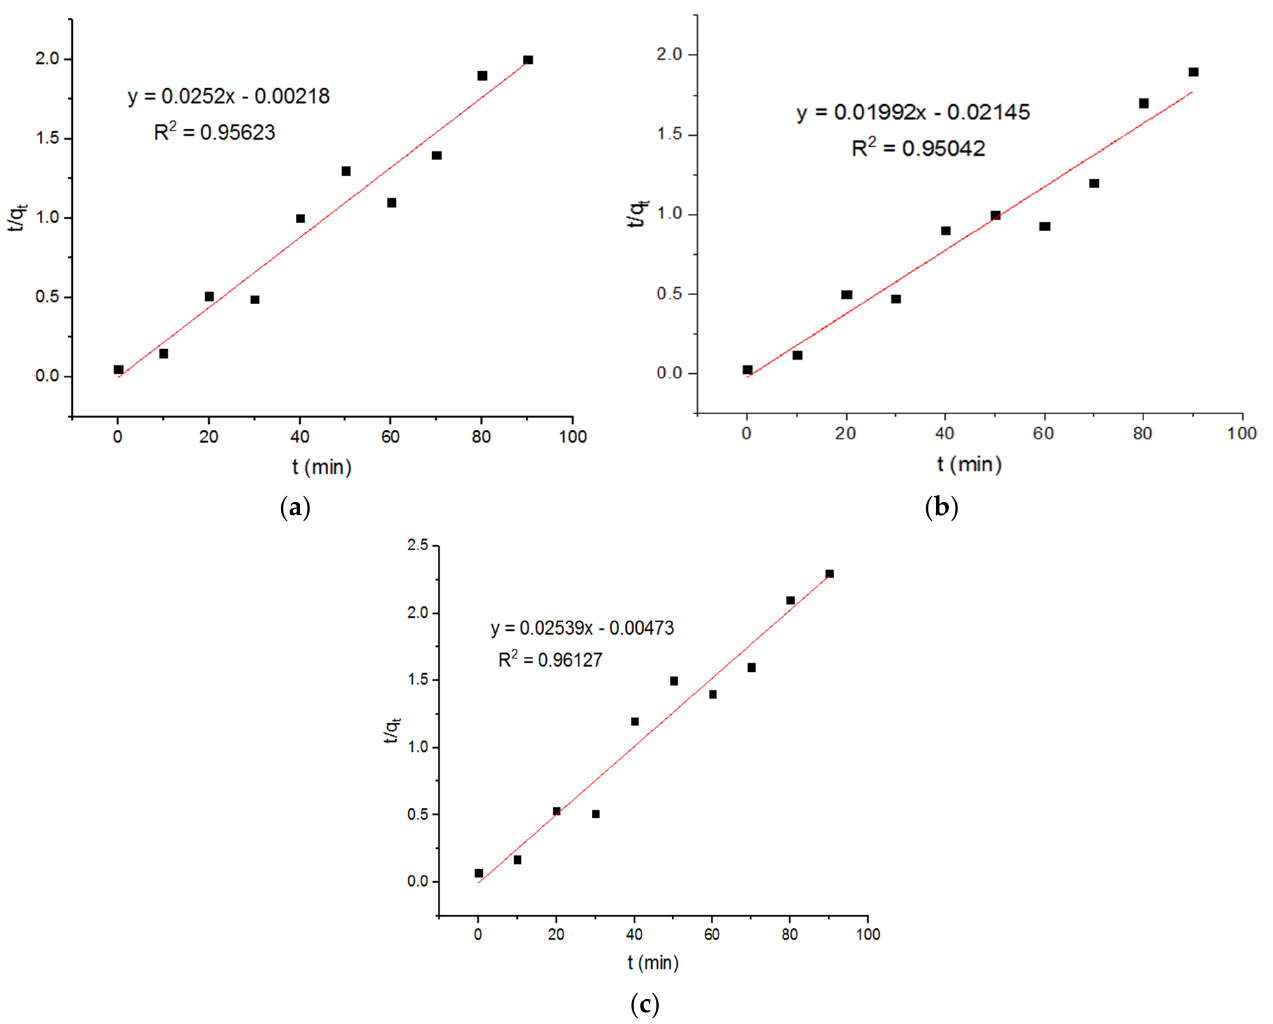
Figure 8. Pseudo-second-order adsorption plots of Cu +2 ions onto MgFe 2 O 4 -NH 2 nanoparticles pre-functionalization-calcined at ( a ) 500 °C, ( b ) 600 °C, and ( c ) 700 °C. Table 1. Pseudo-first- and 2second-order-based adsorption rate constant for Cu +2 ions.